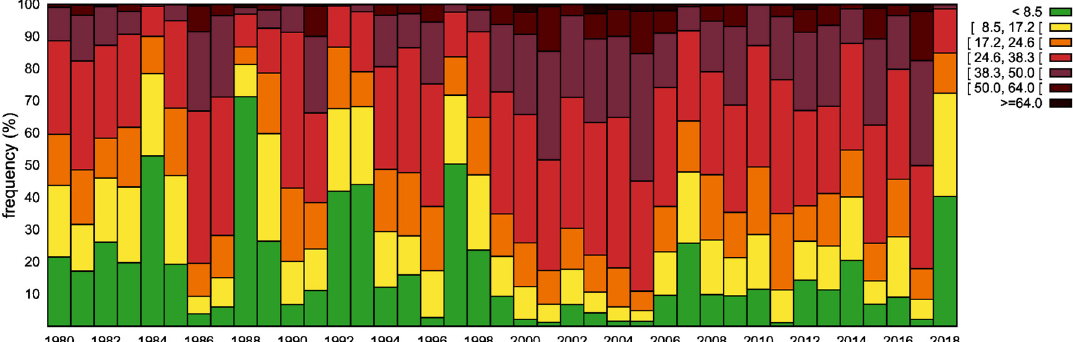
Figure 10. Interannual variation in the average frequencies by FWI danger class in the month of June between 1980 and 2018. The classes shown are currently used by the meteorological and fire management authorities of Portugal [57,58] (p. 231): <8.5, [8.5, 17.1], [17.2, 24.6], [24.7, 38.3], [38.4, 50.0], [50.1, 64.0 ] , >64.